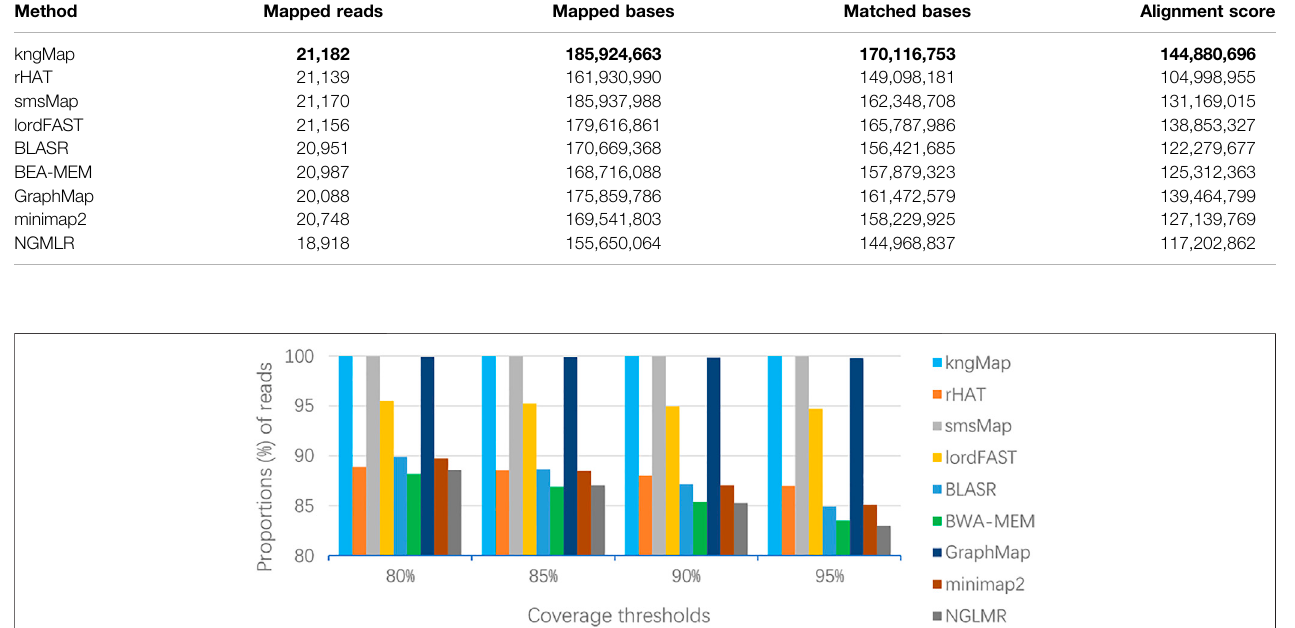
TABLE3| Numberofmappedreads,mappedbases,mappedmatchedbases,andthealignmentscoreofninemethodsonthereal A.thaliana dataset.Thebestresultsare labeled with a bold typeface.